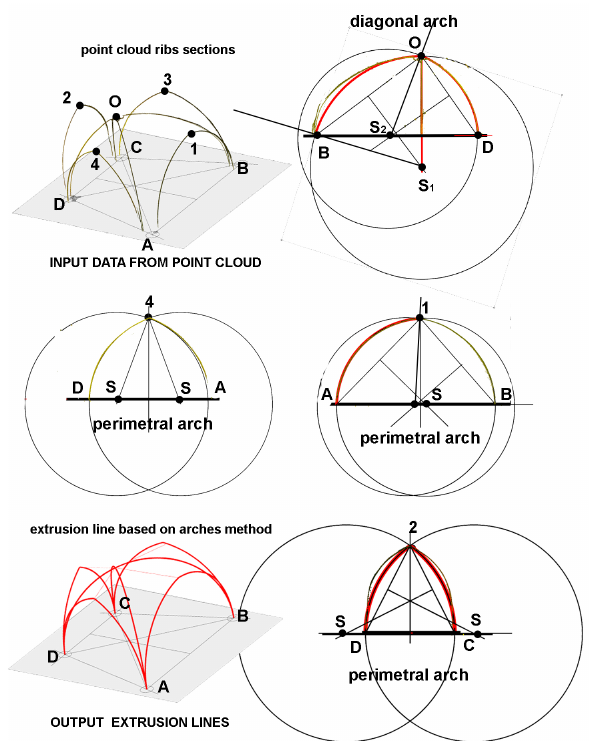
Figure 13 . Church of S. Lorenzo trapezoidal vault: extrusion lines tracing based on arches